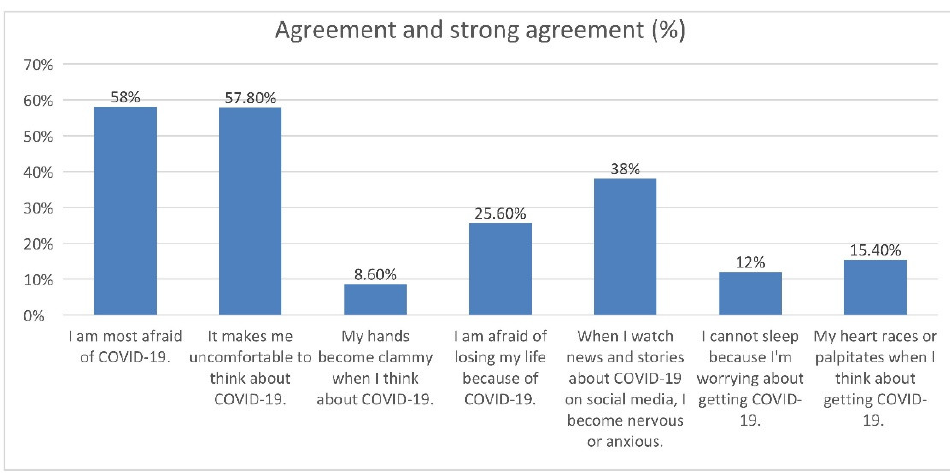
Figure 1. Participants agreement on seven items of The Fear of COVID-19 Scale (FCV-19S ). Table 1. Assessment of fear of COVID-19 infection, based on FCV-19S. Table 1. Assessment of fear of COVID-19 infection, based on FCV-19S. Figure 1 appears below.